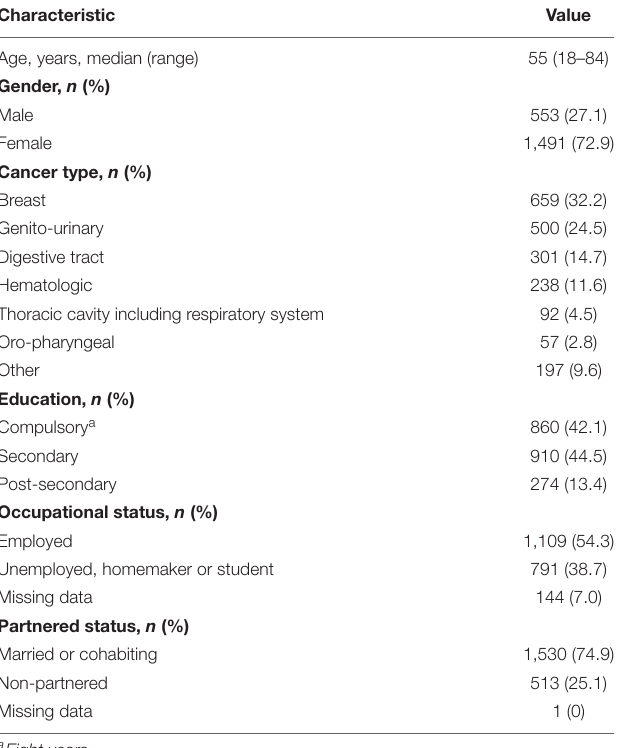
TABLE 1 | Clinical and sociodemographic characteristics of 2,044 cancer